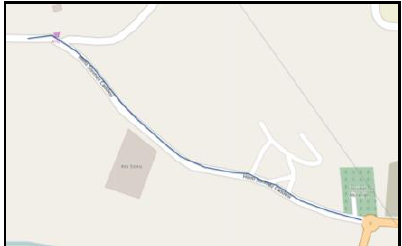
Figure 9. Spatial representation of the selected highway on